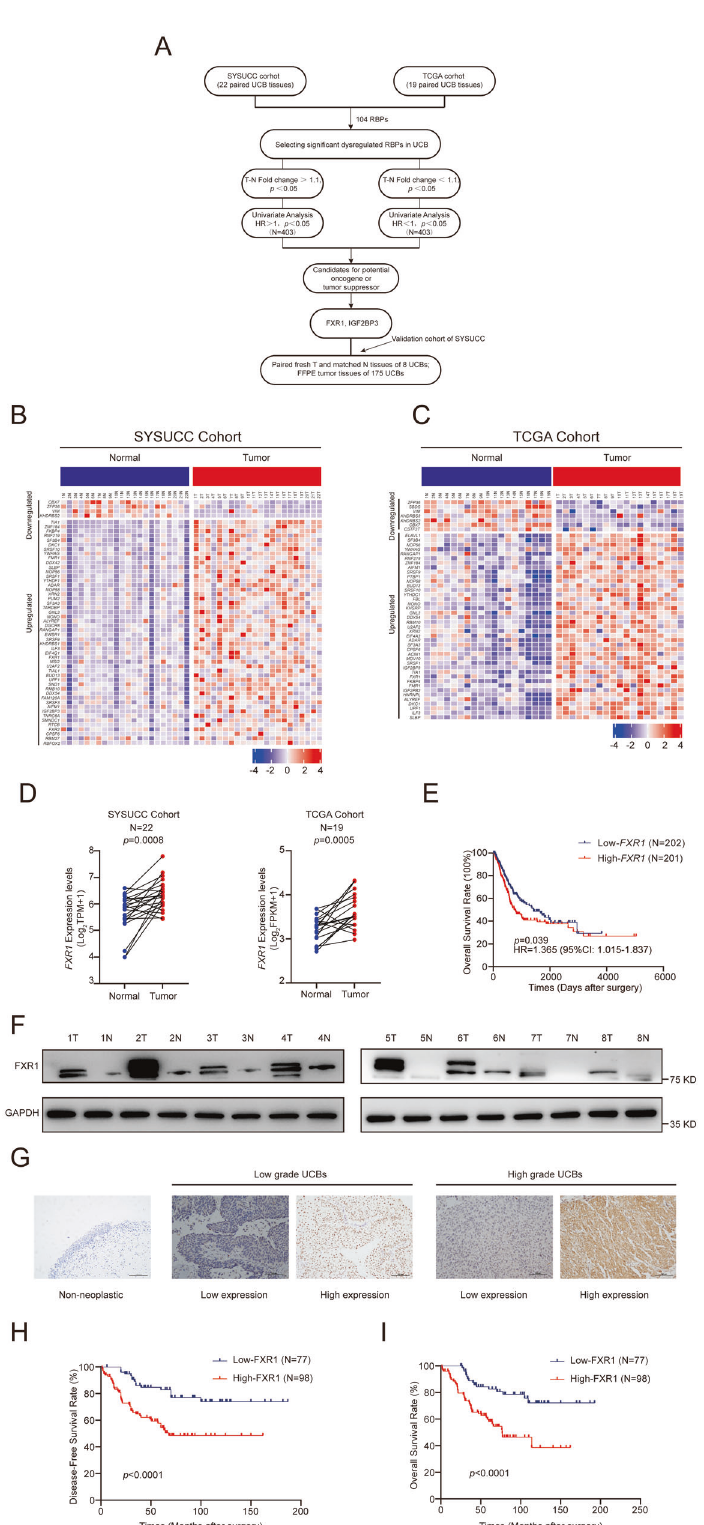
Fig. 1 RBPs are frequently upregulated in UCB tissue and FXR1 upregulation predicts poor DFS and OS in UCB patients from SYSUCC and TCGA cohorts. A Flowchart illustrating the different steps in the analysis of signi fi cantly dysregulated RBPs in UCB patients. B , C Heatmap showing the mRNA expression levels of signi fi cantly dysregulated RBPs in the SYSUCC ( B ) and TCGA ( C ) cohorts. D Distribution of FXR1 mRNA expression in tumors compared with matched normal samples from the SYSUCC (left) and TCGA (right) cohorts. E Survival analysis indicates the correlation between high FXR1 expression levels and poor OS rates in TCGA UCB patients. HR hazard ratio, CI con fi dence interval. F Western blot showing the upregulated expression of FXR1 in eight paired UCB tissues. G Representative images of IHC staining for FXR1 in nonneoplastic bladder tissue, low-grade UCB, and high-grade UCB. H , I Survival analysis showing that high expression of FXR1 predicts poor DFS and OS rates in SYSUCC UCB patients. Cell Death and Disease (2022)